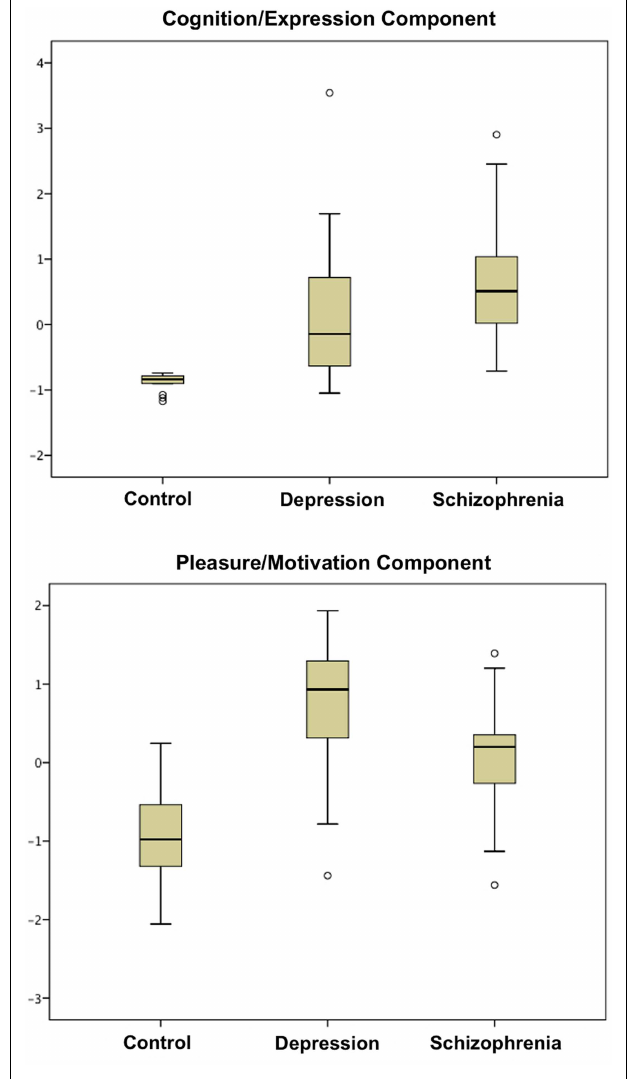
FIGURE 1 | Boxplots of scores in cognition/expression component and pleasure/motivation component are shown . Both patient groups are significantly different from the control group in these two components ( Table 1